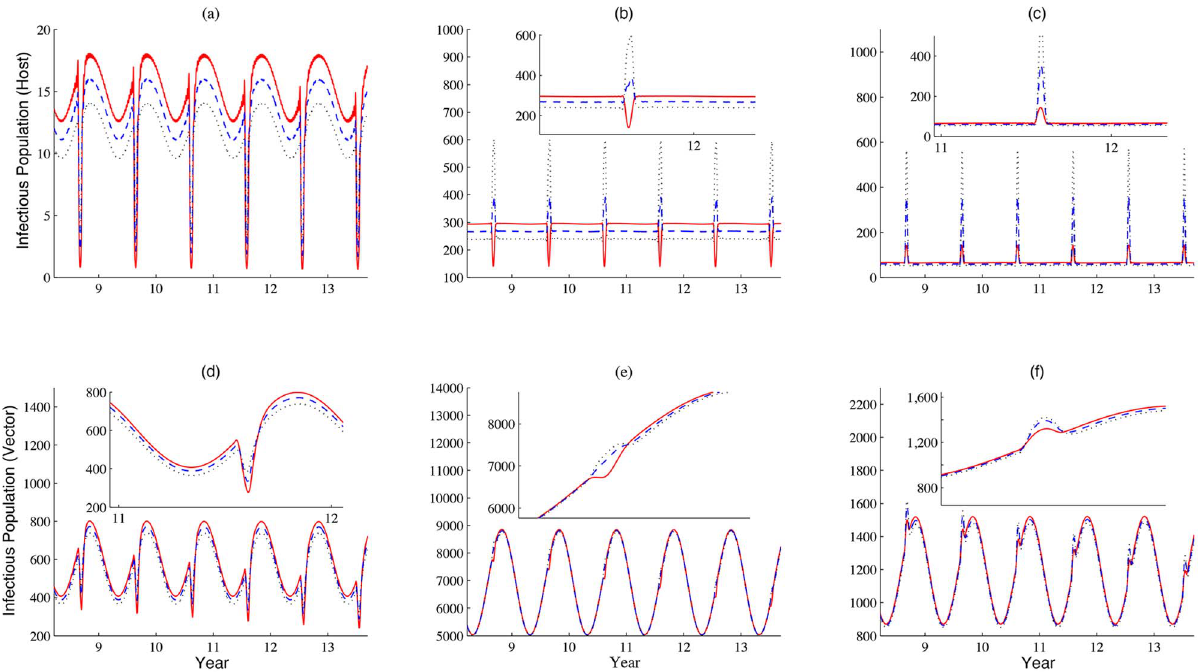
Fig. 9. How daily increment in the daily imported number of livestock impacts patterns of disease outbreaks. (a)-(c) and (d)-(f) show the populations of infectious livestock and vectors in patches 1–3, respectively. The increment dr on the daily imported number in patch 1 are 20, 100 and180 per day, represented by solid, dashed and dotted lines, respectively. Values of other parameters are identical with those used in Fig. 3 and dc ~ 54 (km per day).